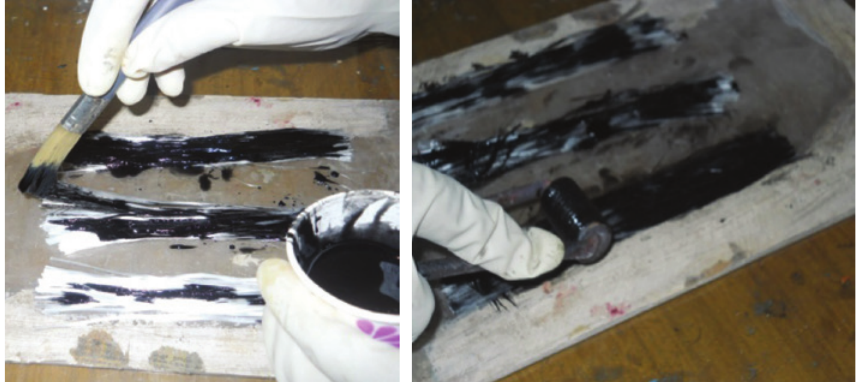
Figure 1: Preliminary arrangement of the fabrication